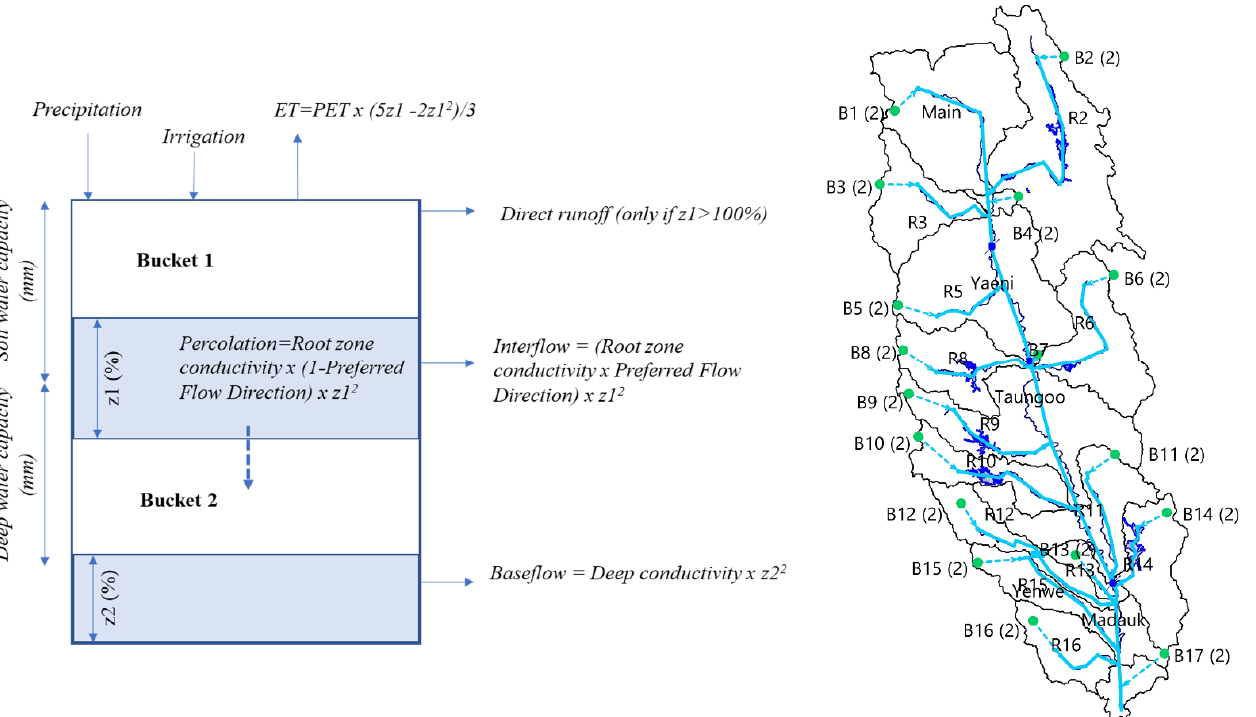
Figure 3. Soil Moisture method used in the WEAP model set for the Sittaung river basin.